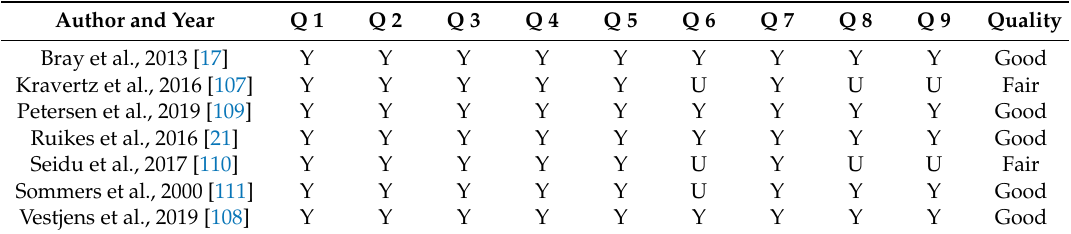
Table A6. Quality assessment of non-randomised controlled studies using JBI critical appraisal checklist.